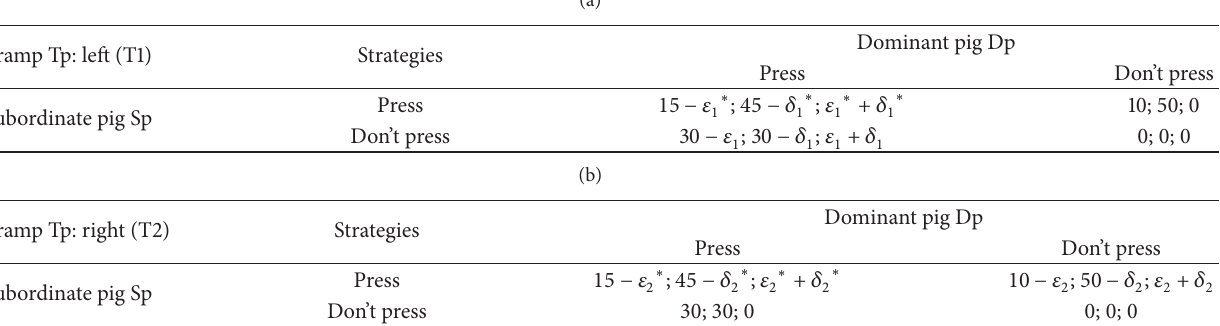
Table 3: Rational Pigs Extended (generally applicable to three players).